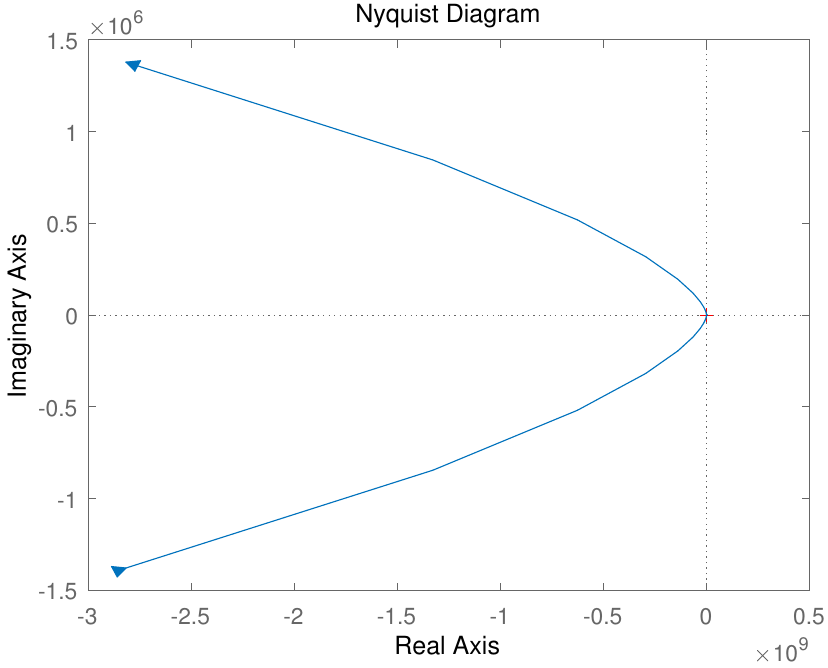
Figure 6. Nyquist diagram under the fractional-order PD controller K p = 1408.5, K d = 488.1, α =